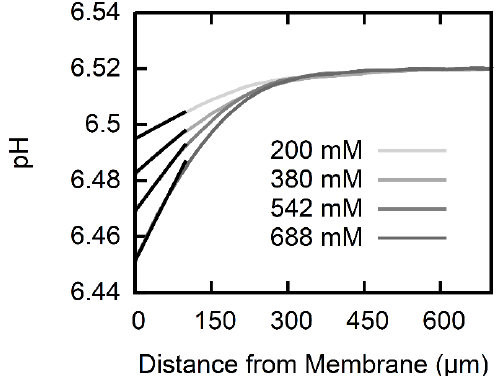
Figure 2. pH profiles induced by AscH transmembrane flux. The pH in the cis compartment (100 mM KCl, 0.5 mM ß-alanine, 0.3 mM KH 2 PO 4 adjusted to pH ~6.5) acidifies within the USL, since part of the AscH molecules that arrive from the trans-compartment (100 mM KCl, 0.5 mM ß-alanine, 0.3 mM KH 2 PO 4 adjusted to pH 4.25) deprotonate. The different concentrations of Na- L -ascorbate in the trans-compartment (see inset) range from 200 mM (light gray) to 688 mM (dark gray). Numerically